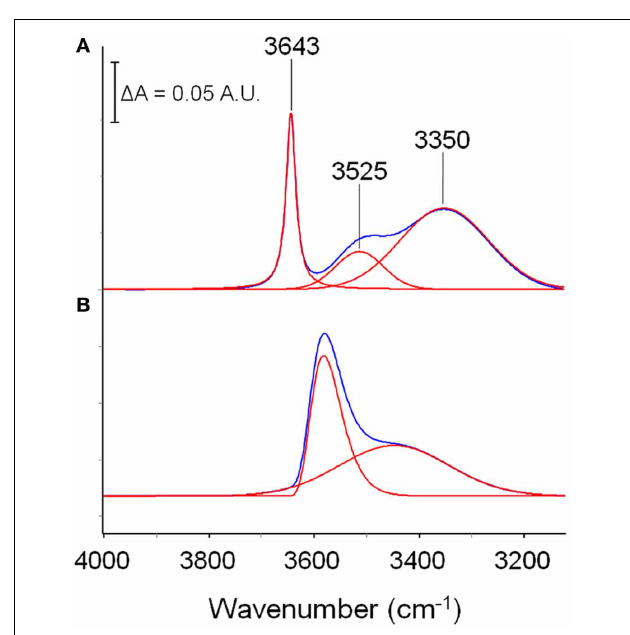
Figure 4 | Comparison between the spectrum of a methanol solution in CCl 4 (0.10M) and the spectrum of methanol sorbed in PMDA-ODA ( p / p 0 = 0 . 3). The absorbance scale refers to traces (A) ; traces (B) have been expanded to full-scale to facilitate the